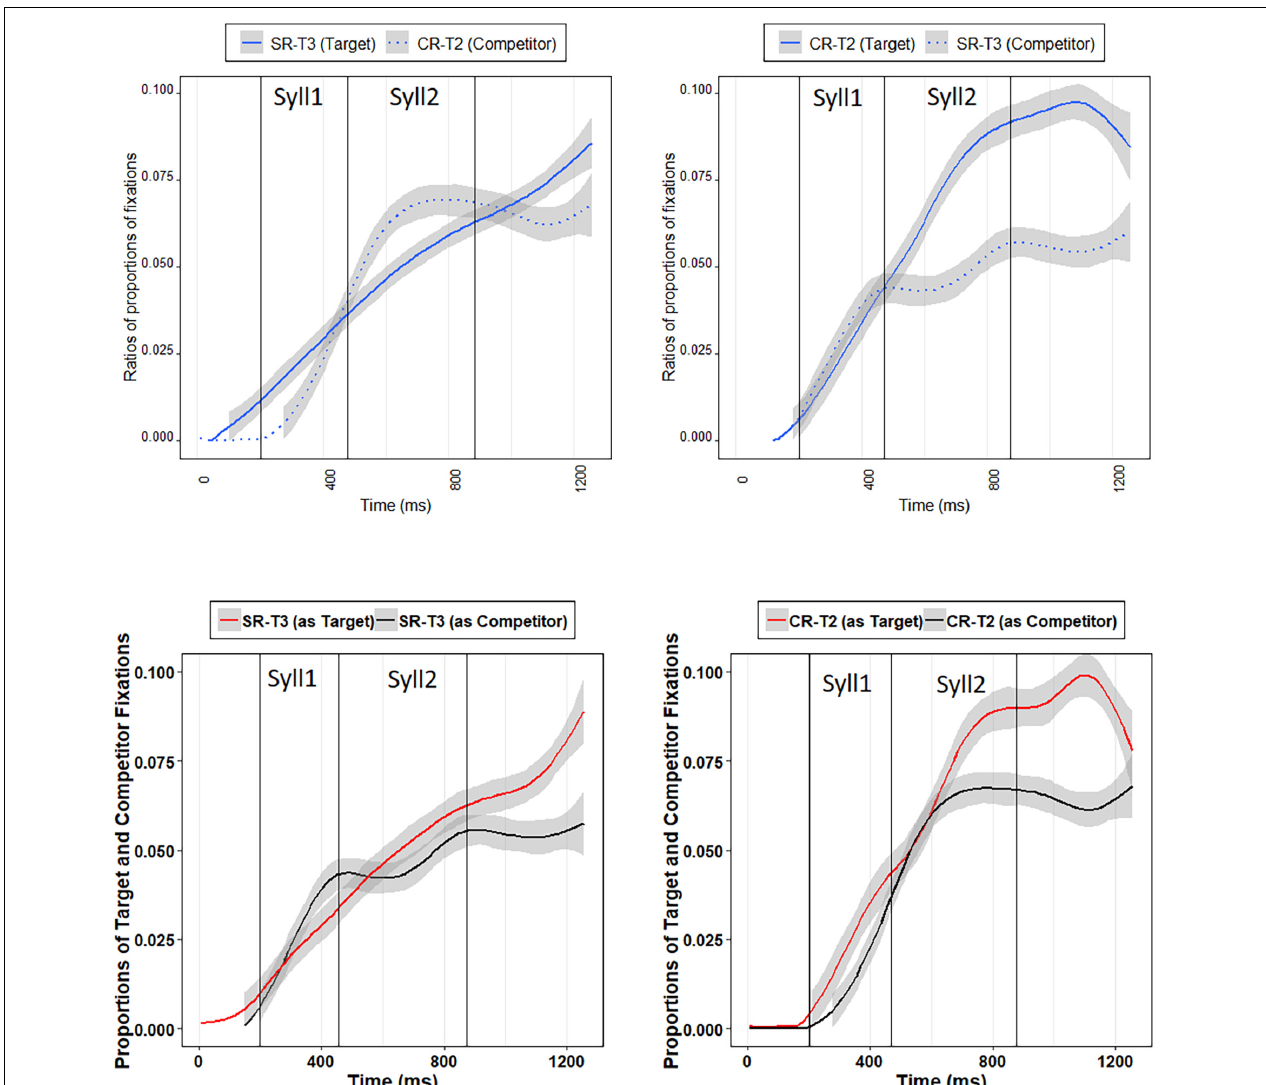
FIGURE 4 | Top-left panel: SR-T3 target ratios and CR-T2 competitor ratios when Mandarin listeners hearing SR-T3 words; top-right panel: CR-T2 target ratios and SR-T3 competitor ratios when Mandarin listeners hearing CR-T2 words; bottom-left panel: Mandarin listeners’ proportions of fixations to SR-T3 targets and SR-T3 competitors; bottom-right panel: Mandarin listeners’ proportions of fixations to CR-T2 targets and CR-T2